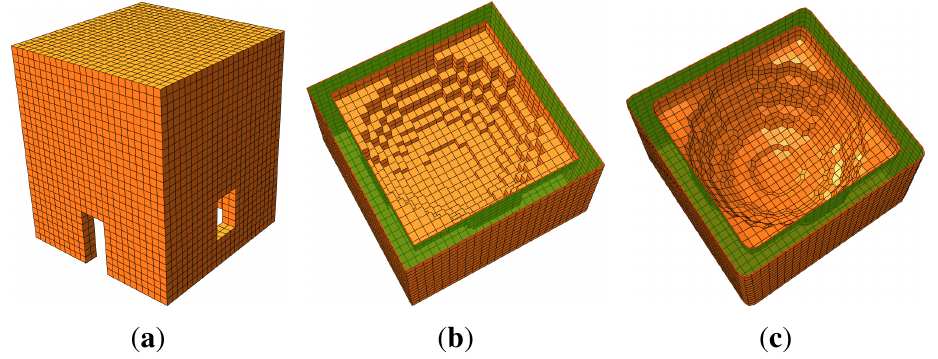
Figure 5. Finite element mesh obtained by applying the procedure to the structure represented in Figure